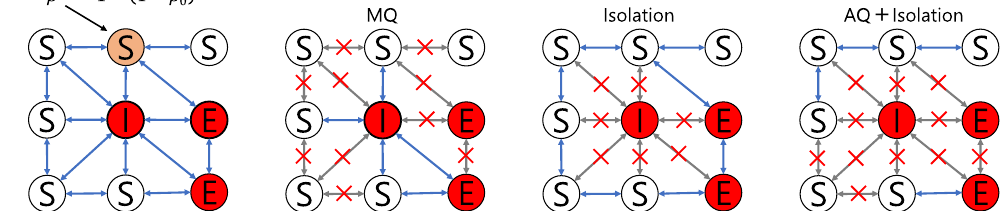
Figure 4. Transmission rates are displayed in the leftmost panel. Diagrams of the three interventions are